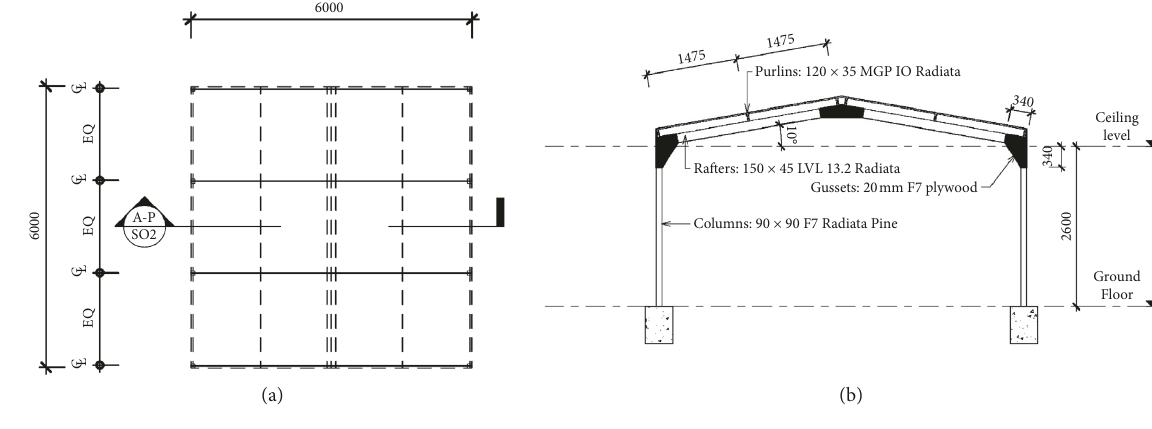
Figure 3: Portal frame case A. (a) Layout. (b) Cross Table 1: Summary of designed portal elements.